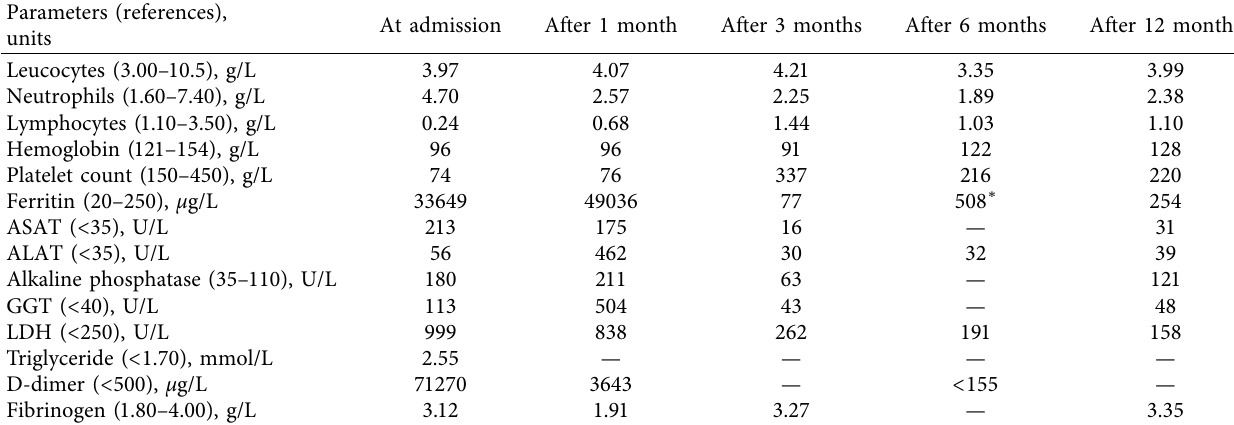
Table 2: Laboratory fndings.